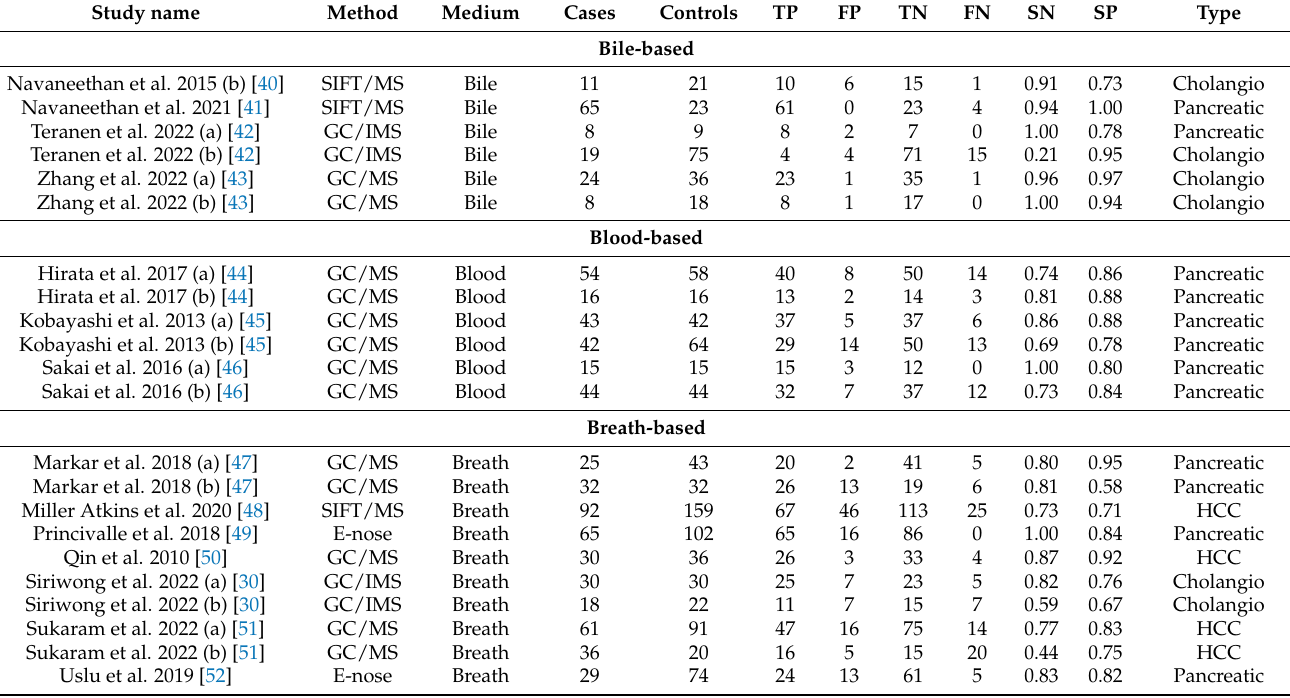
Table 1. Basic characteristics of the studies for volatile organic compounds in the detection of hepatobiliary and pancreatic cancer and their true positive (TP), true negative (TN), false positive (FP), and false negative (FN)